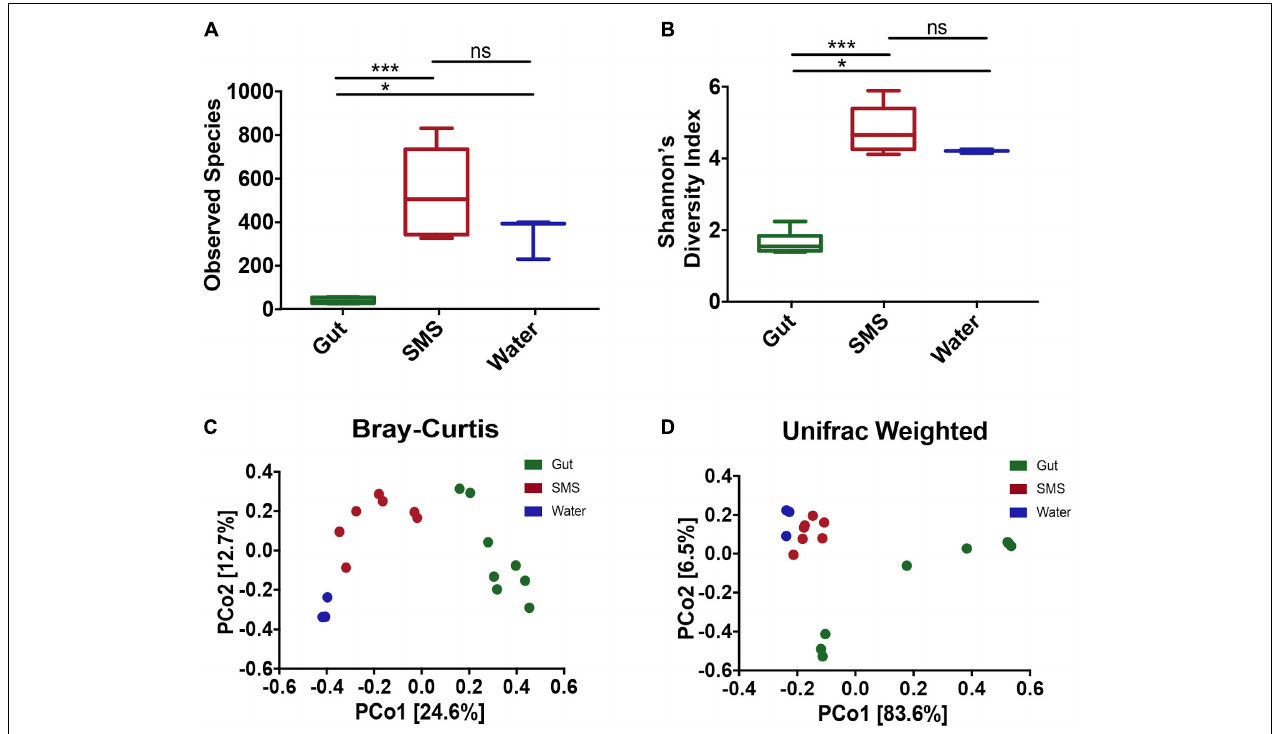
FIGURE 1 | Alpha and Beta Diversity Analyses of the SMS, the Gut, and the Water Communities. Alpha-diversity was calculated using the metrics of (A) Observed ASVs and (B) Shannon’s Diversity Index. Statistical analysis was conducted on alpha diversities using Mann-Whitney tests. ns, not significant; p > 0.05, ∗ p < 0.05, ∗∗∗ p < 0.001. Beta-diversity was calculated and principle coordinate analysis (PCoA) was performed using the metrics of (C) Bray–Curtis Dissimilarity and (D) Weighted UniFrac. A PERMANOVA was used to detect significant differences in the beta-diversities. For the Bray–Curtis Dissimilarity PCoA, all communities clustered separately ( p -value = 0.002, 0.007, 0.014 for SMS-gut, gut-water, and SMS-water, respectively). The weighted Unifrac revealed separate clustering between the SMS and gut as well as the gut and water communities ( p -value = 0.001, 0.008), but the distance between the SMS and the water was non-significant ( p -value =